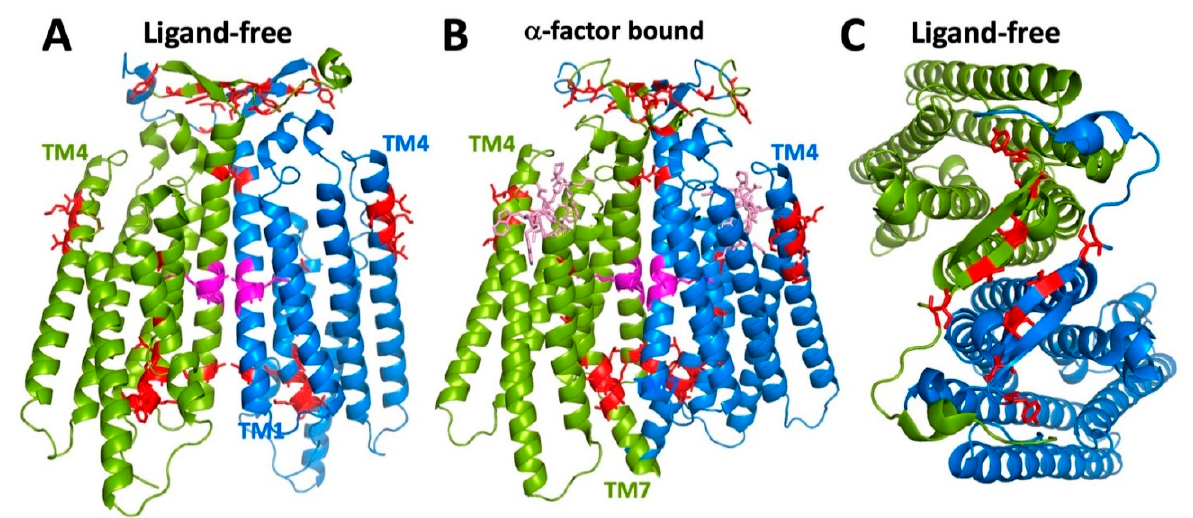
Figure 9. Locations of intermolecular disulfide crosslinks detected between Ste2p monomers. ( A ) Sites of crosslinks between introduced cysteine substitutions are shown mapped to the ligand-free Ste2p structure (PDB code: 7QB9) as red stick representations shown in a view parallel to the membrane. Ste2p monomers are shown in blue and green. The positions of residues constituting the GxxxG motif in TM1 implicated in contacts between monomers are shown as magenta sticks. ( B ) Sites of crosslinks between introduced cysteine substitutions are shown mapped to the structure of Ste2p in the activated receptor-G protein complex (PDB code: 7AD3) (coloring as in (panel A ), with bound α -factor shown as pink sticks). ( C ) Sites of intermolecular crosslinks detected in the N-terminal tail of Ste2p shown in the structure of the ligand-free receptor (PDB code: 7QB9) viewed from the extracellular side of the membrane. Ste2p monomers are shown in green and blue. Sites of crosslinking in the N-terminal tail are shown as red sticks.